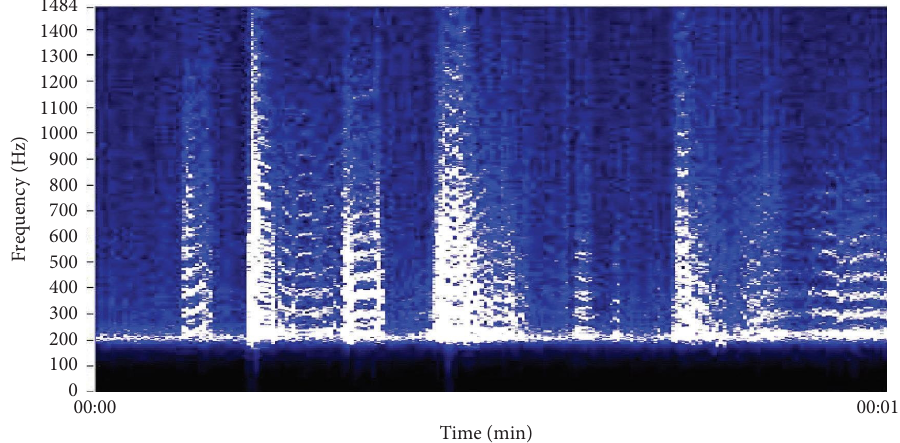
Figure 7: Power spectrum of the received signal over time.